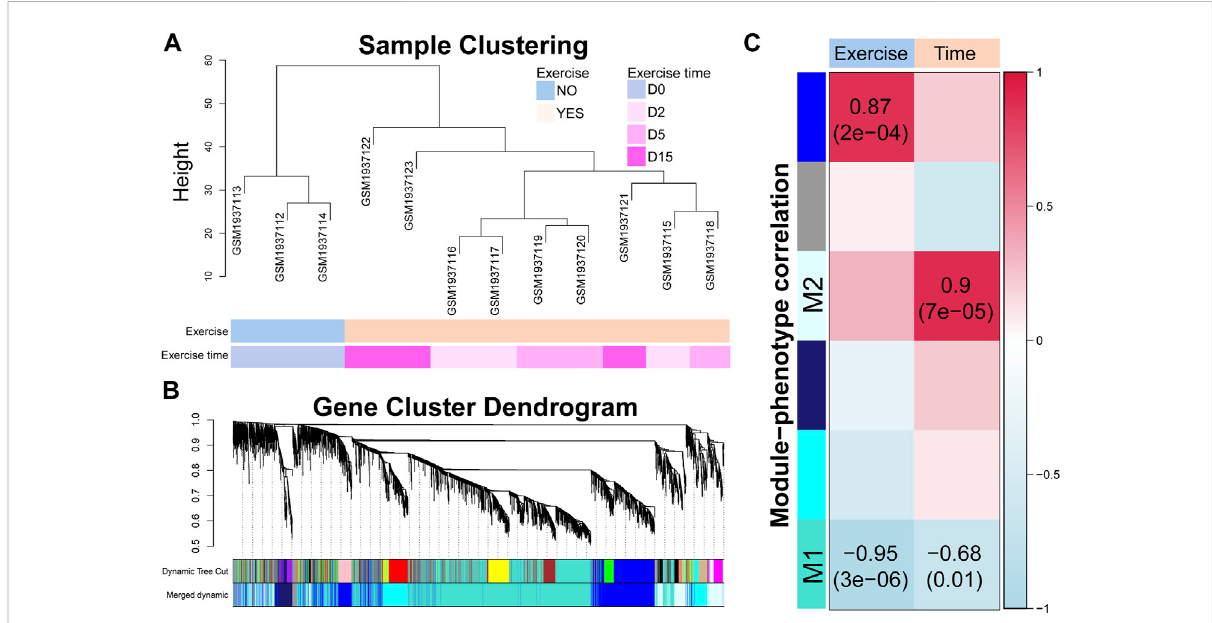
FIGURE 3 Time-correlated gene modules are identi fi ed by modularization method. (A) Sample clustering dendrogram based on the Euclidean distance. (B) Gene cluster dendrogram calculated by average linkage hierarchical clustering. The color row underneath the dendrogram shows the assigned original modules and the merged modules. (C) Correlation between module eigengene and exercise or exercise time. The value in each square and the p -value in parentheses re fl ect the correlation coef fi cient. p < 0.05 is considered statistically signi fi